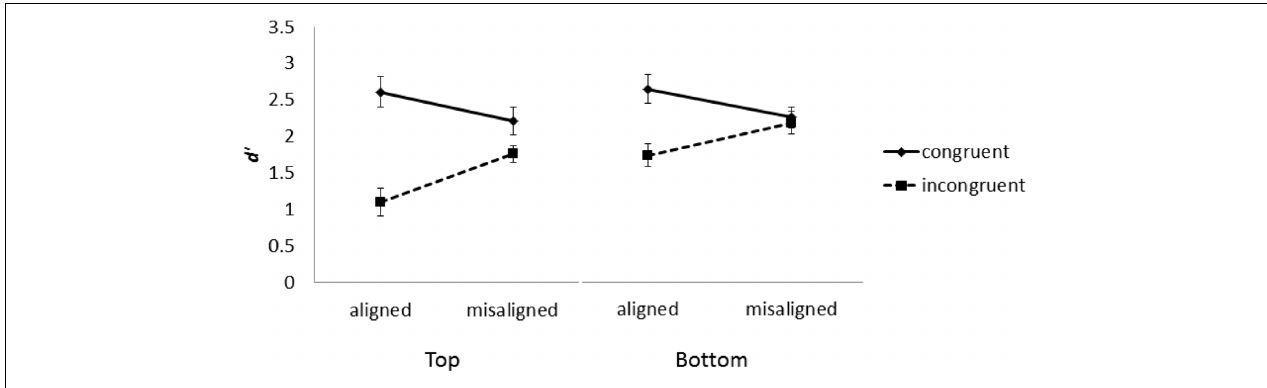
FIGURE 4 | Performance in the complete composite task for top and bottom halves in Experiment 1. Error bars indicates ± 1 standard error of mean.